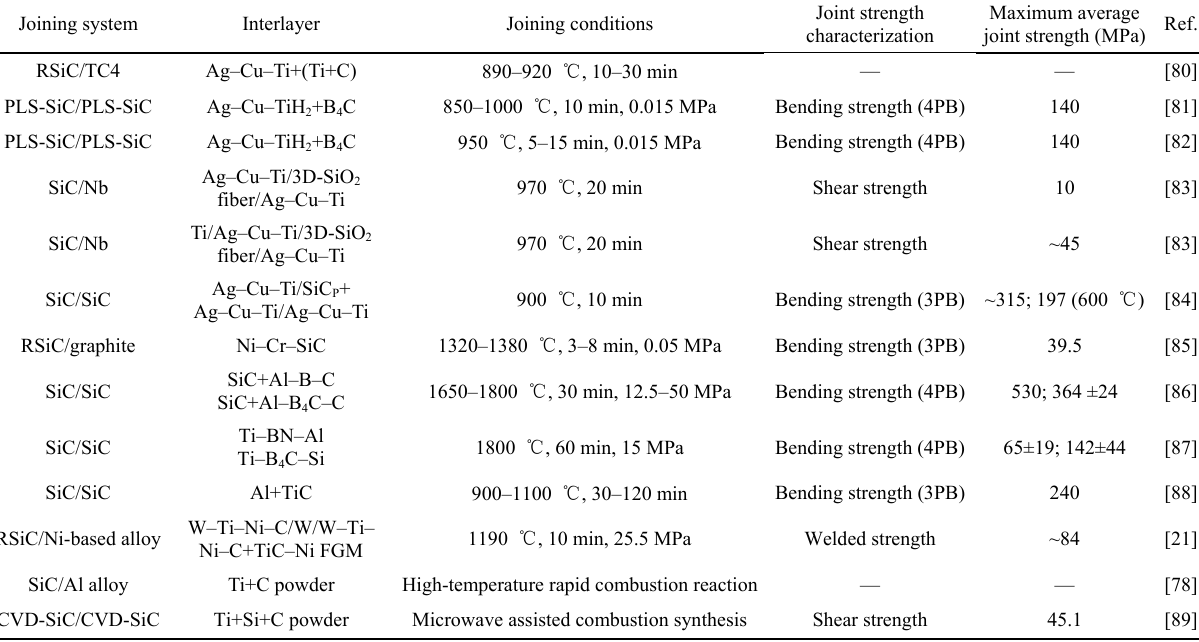
Joining of SiC-based materials using metal-ceramic hybrid materials as interlayer: interlayer, joining conditions, and joint strength Joining